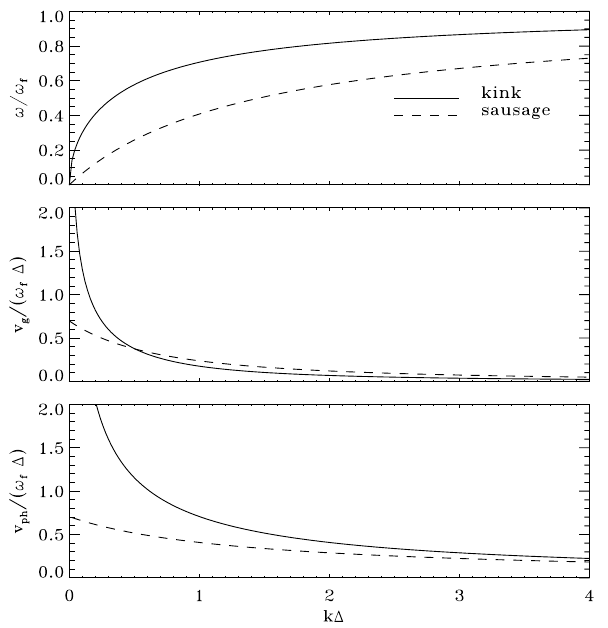
Fig. 3. Frequencies, group and phase velocities as functions of wave number for the “kink” and “sausage” wave modes for the uniform background plasma density.